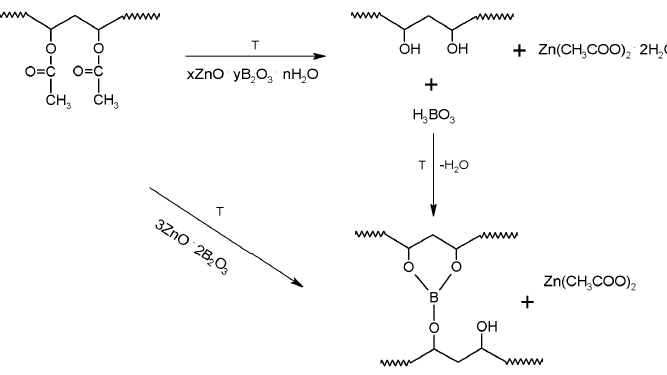
Scheme 1. A scheme of PVAc crosslinking process by hydrated and anhydrous zinc